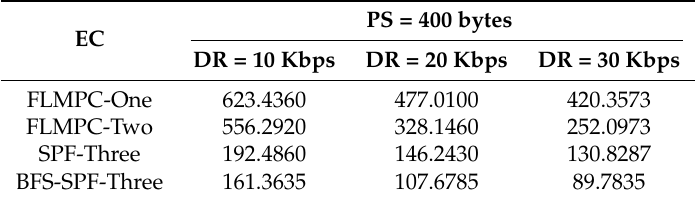
Table 8. EC Values with PS of 400 bytes.